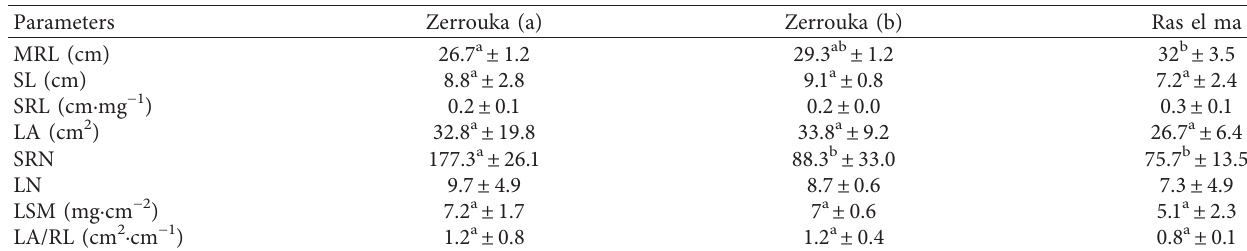
Figure 1: Growth of seedling organs: (a) Dry mass in mg/organ, (b) water content in %, (c) dry mass in % of dry mass of the whole plant, and (d) dry mass in % of dry mass of all the roots of the plant. The different letters in upper and lower case indicate the significant differences ( P < 0 . 05, n � 3). The absence of letter indicates no significant difference at P < 0 . 05 except for SDM. LDM: leaf dry mass; SDM: stem dry mass; MRDM: main root dry mass; SRDM: secondary root dry mass; WPDM: whole plant dry mass; L: leaves, S: stem; MR: mean root; SR: secondary roots. Table 2: Variation of seedling growth